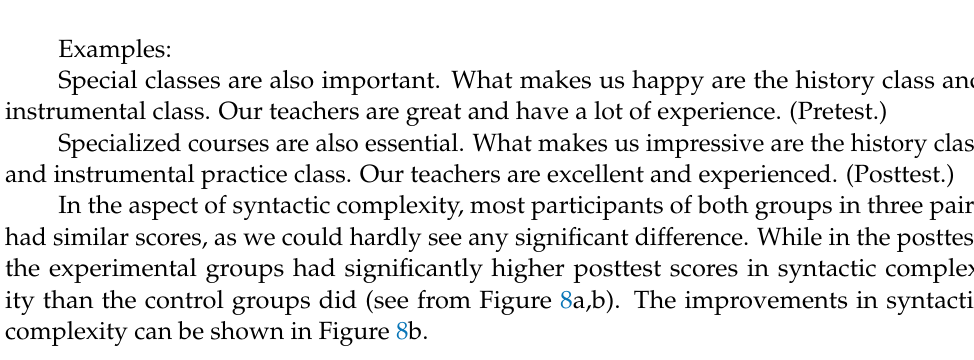
Figure 7. Comparison of pre-and posttests scores. ( a ) Comparison of pretest lexical complexity. ( b ) Comparison of posttest lexical complexity.